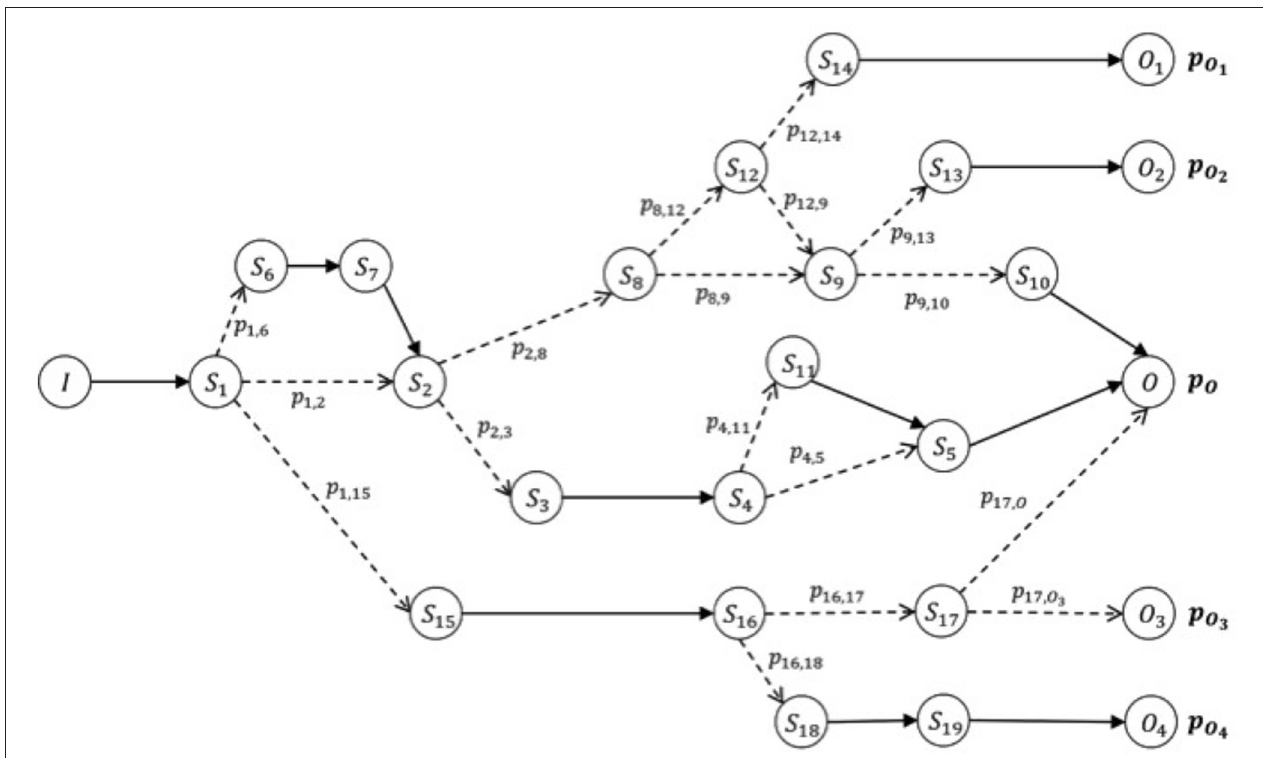
FIGURE 2 | Oriented graph of possible patient journeys. Example of a graph that models the data collected for a cluster of journeys, according to their specific initial features (condition on admission), I . The expected (or positive) result of this path is O , which can be reached with probability pO . The patient’s risk is defined by the probability of reaching different final conditions given the same starting condition upon admission. The risk of obtaining a final condition different from O , starting from condition I on admission, is given by the list of probabilities [p (O1), p (O2), p (O3), p (O4)] . Each node of the graph represents a possible step (initial, intermediate, or final) of the journey (and thus a stage of the patient’s condition between admission and discharge), and each edge (or line between nodes) represents a possible succession of steps/stages according to the probability of encountering each of them. Such journeys make up our knowledge base. In particular, we can calculate the probability of arriving at the final step/stage, given any initial node of the graph, be it initial or